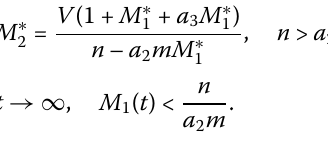
(ii) The unique positive equilibrium point of the system can be computed solving